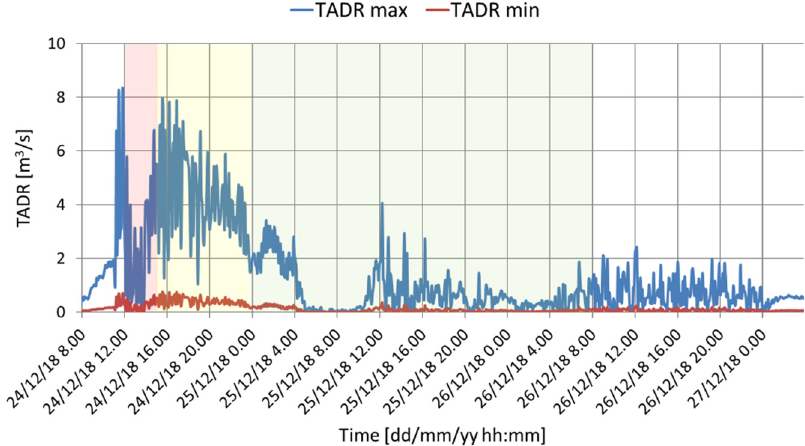
Figure 4. Time Averaged Discharge Rate (TADR) time series derived from SEVIRI data from 24 to 27 December 2018. Blue and maroon lines indicate the maximum and minimum TADR values respectively. The red, yellow, and green areas emphasize the influence of volcanic plume, the lava flow, and the presence of meteorological cloud.